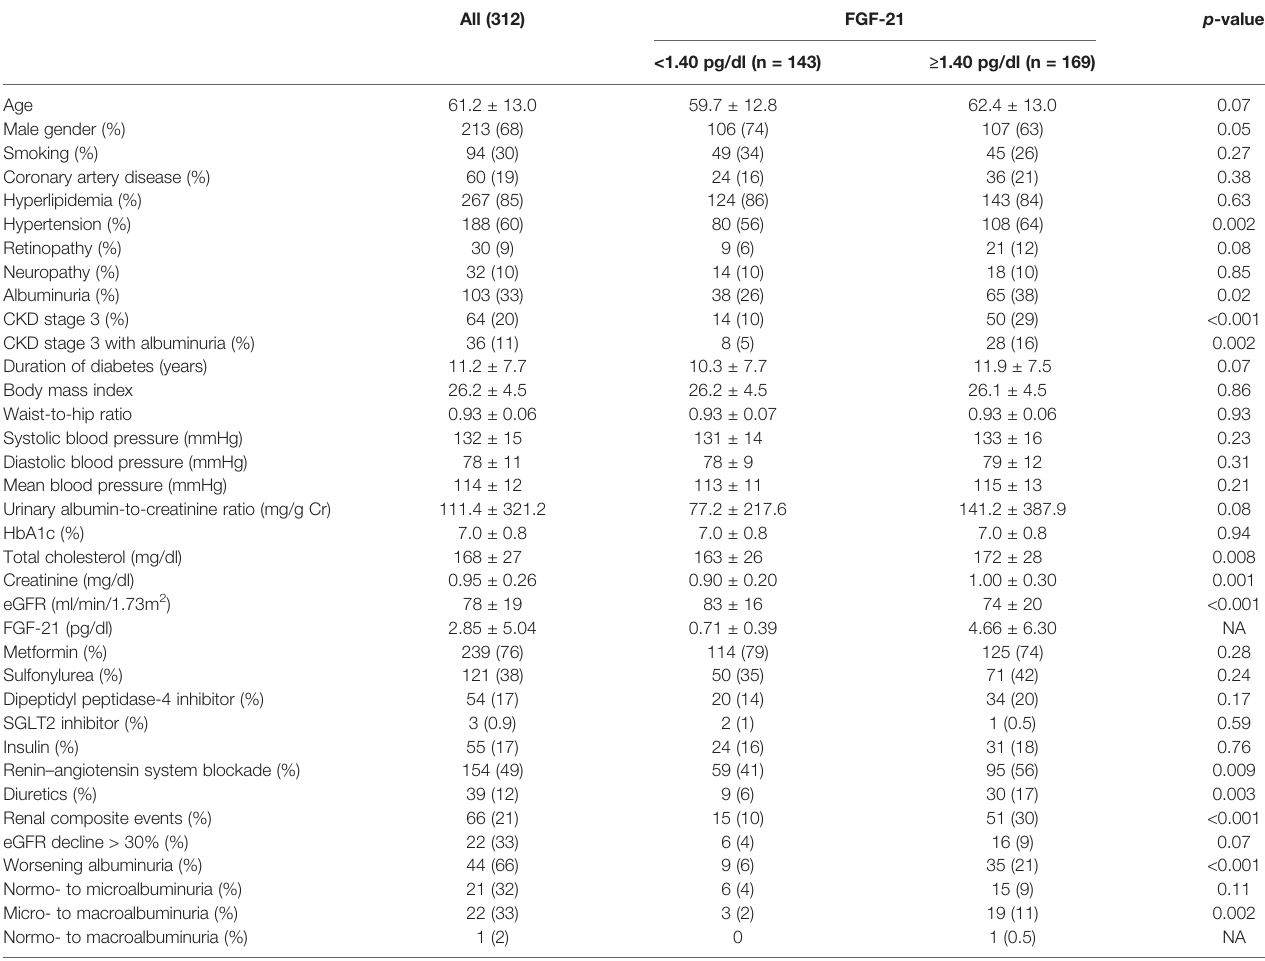
TABLE 3 | Baseline characteristics and renal outcomes of subjects with T2DM grouped by FGF-21.